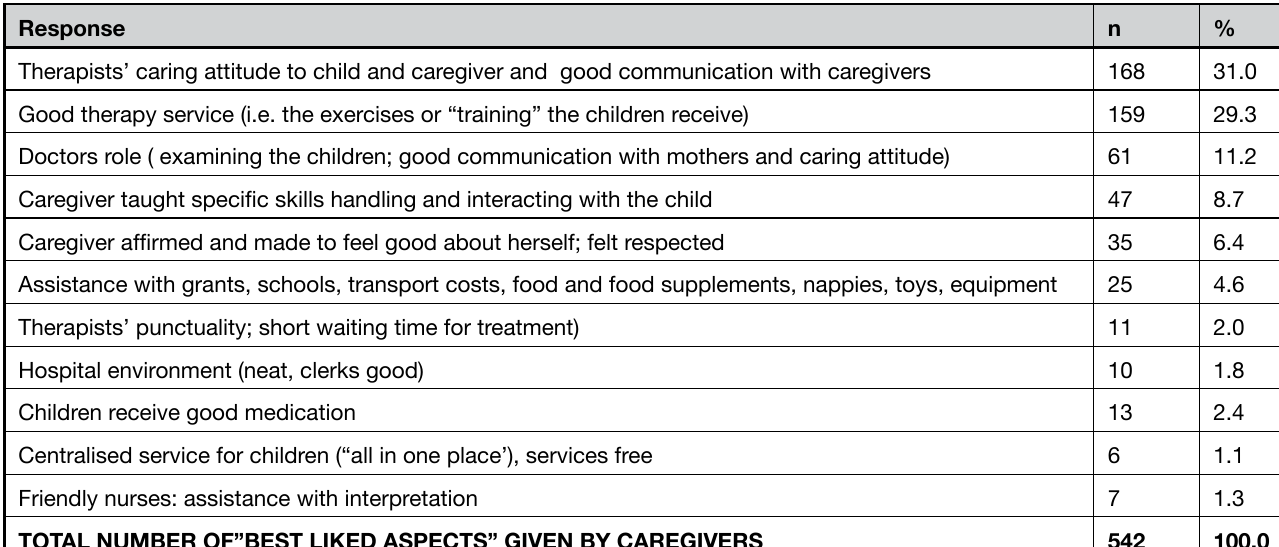
Table 1: Number of responses relating to what caregivers liked best about the service (n=542)